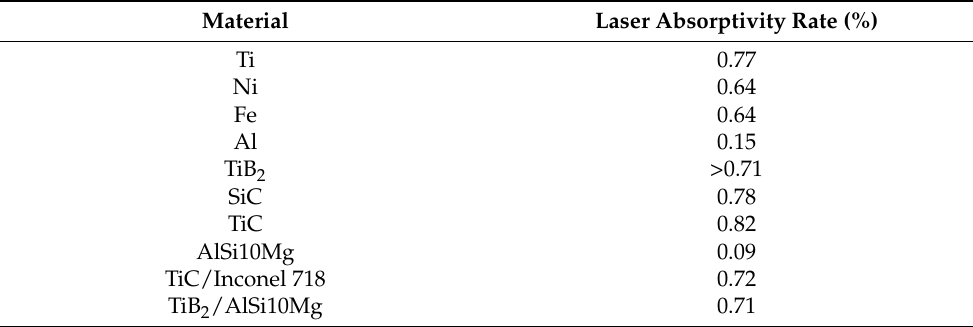
Figure 3. SEM image of the interface layer between TiC and matrix [60]. Table 3. LAR of alloys, ceramics and composites powders